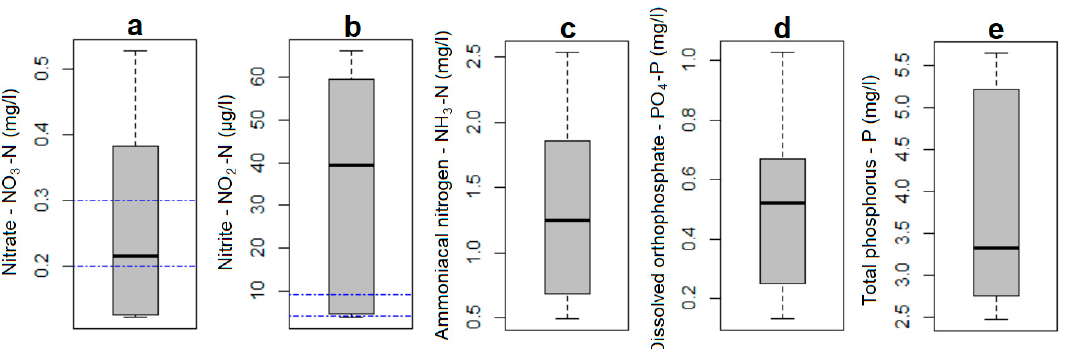
Figure 4. Analysis of the samples collected in the El Vado CSO for ( a ) nitrate, ( b ) nitrite, ( c ) ammoniacal nitrogen, ( d ) dissolved orthophosphate and ( e ) total phosphorus. Two CSO events were recorded: 4 April 2018 and 9 May 2018. The blue dot and dash line represent the values recorder in the Tomebamba River in the rainy season [24].